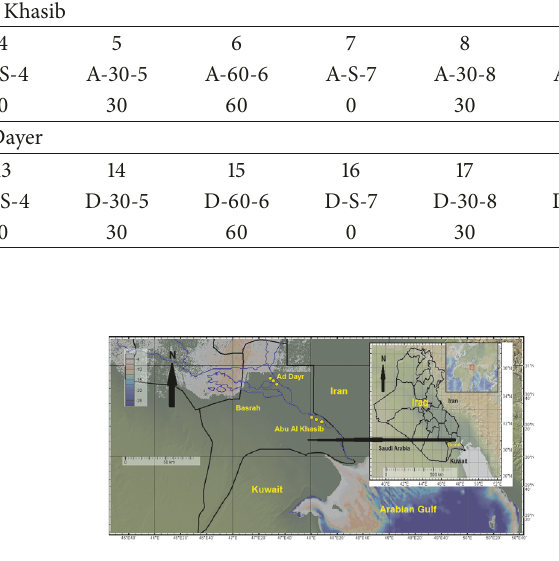
Figure 1: Map of the surveyed area conducted using geomapapp